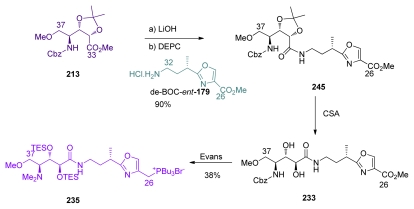
Preparation of C26–C37 235 by Shioiri.